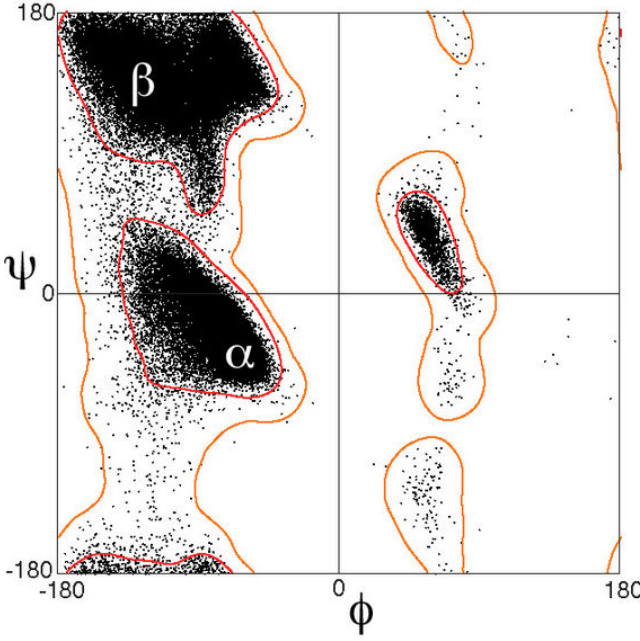
Figure 4. Ramachandran diagram